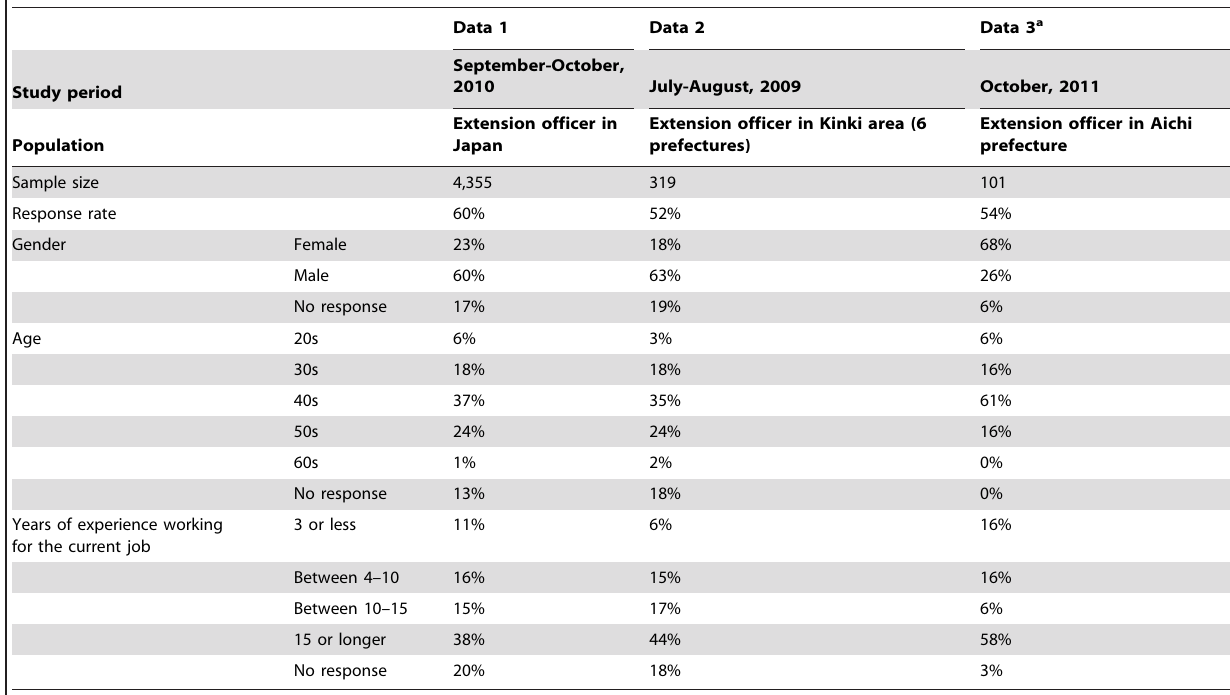
Table 1. Summary of respondent